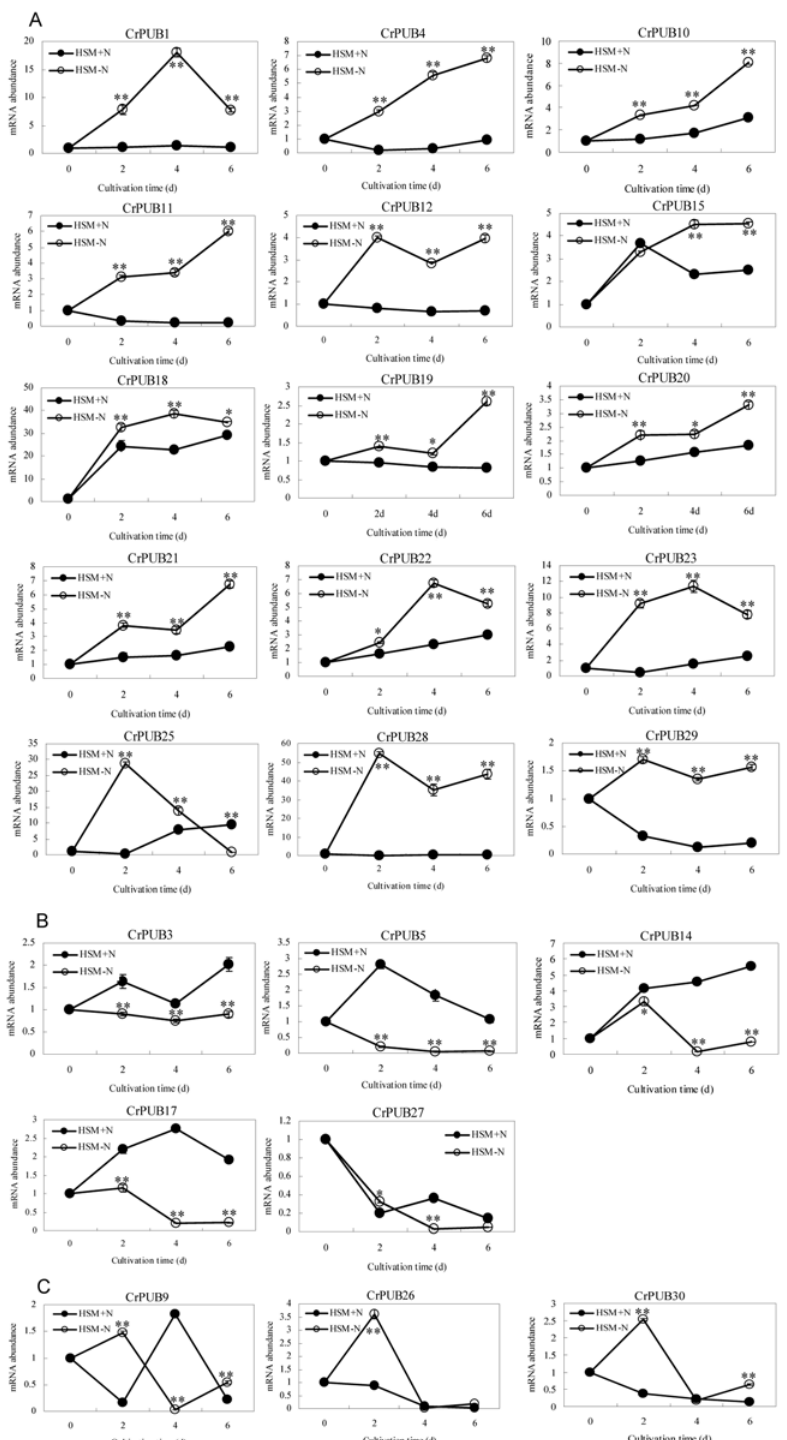
Fig 6. Results of qPCR analysis of the CrPUB genes. A. N starvation up-regulated the mRNA expression of 15 CrPUB genes as shown by real-time PCR analysis. B. The transcription of 5 CrPUB genes was repressed under N starvation. C. CrPUB9, CrPUB 26 and CrPUB30 were all expressed under both N starvation and normal conditions; however, no relationship between mRNA abundances and N starvation was found. C . reinhardtii CC124 were pre-cultured in HSM to the mid-logarithmic phase, followed